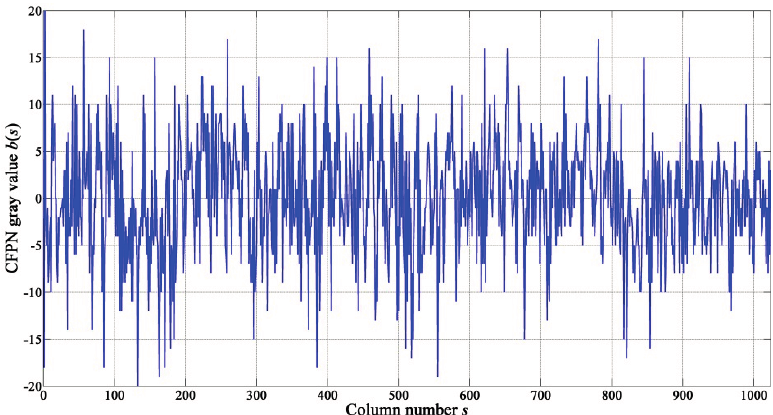
Figure 10. Estimated CFPN gray value ( ) b s versus s .